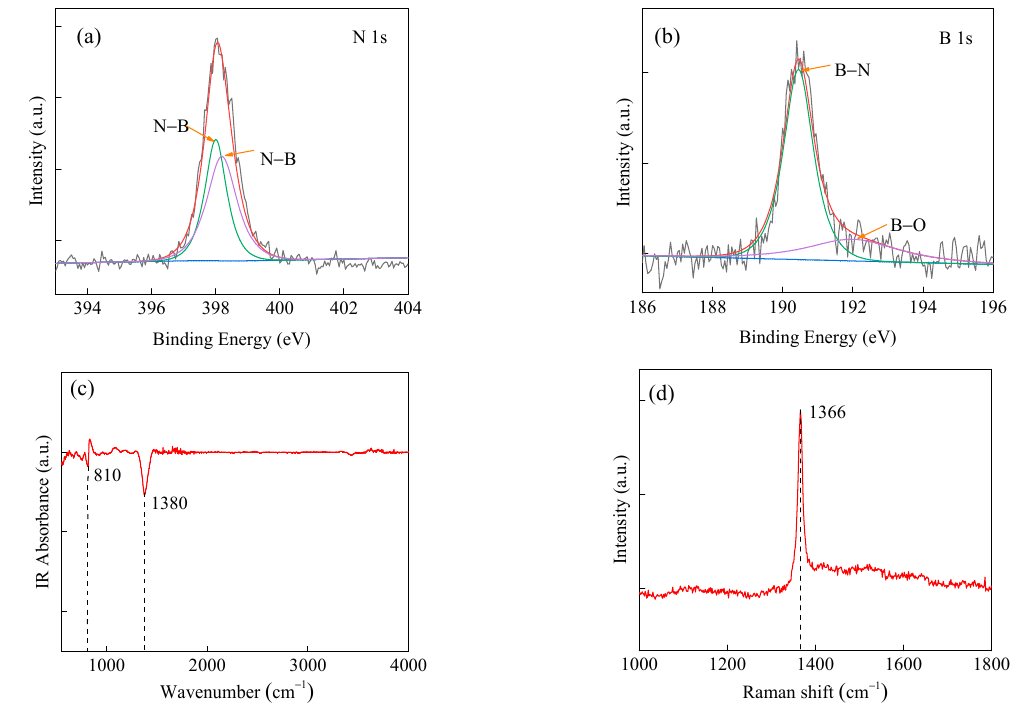
Figure 2. ( a , b ) XPS of BNNRs. ( c ) FTIR. ( d ) Raman scattering spectrum. Figure 2c shows the Fourier Transform Infrared Spectroscopy (FTIR) of BN powder.